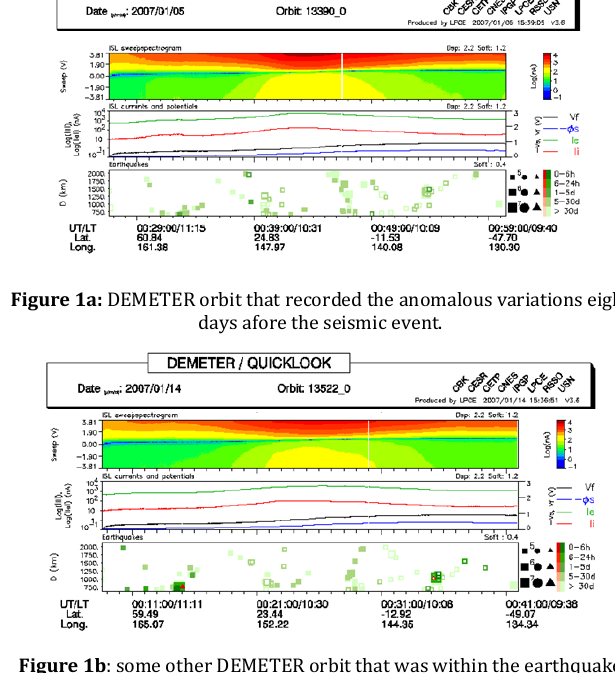
Figure 1b : some other DEMETER orbit that was within the earthquake preparation zone during our period of